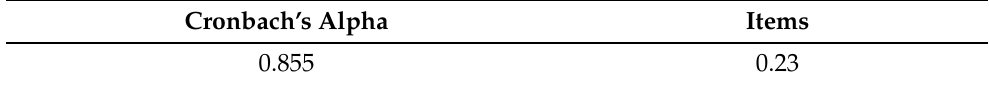
Table 11. Reliability test related to financial factors of management control